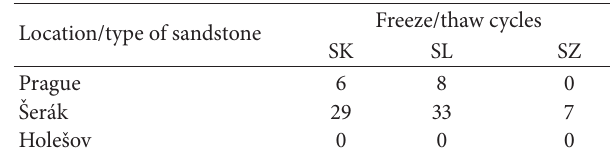
Table 10: Summary of freeze/thaw cycles appearance.